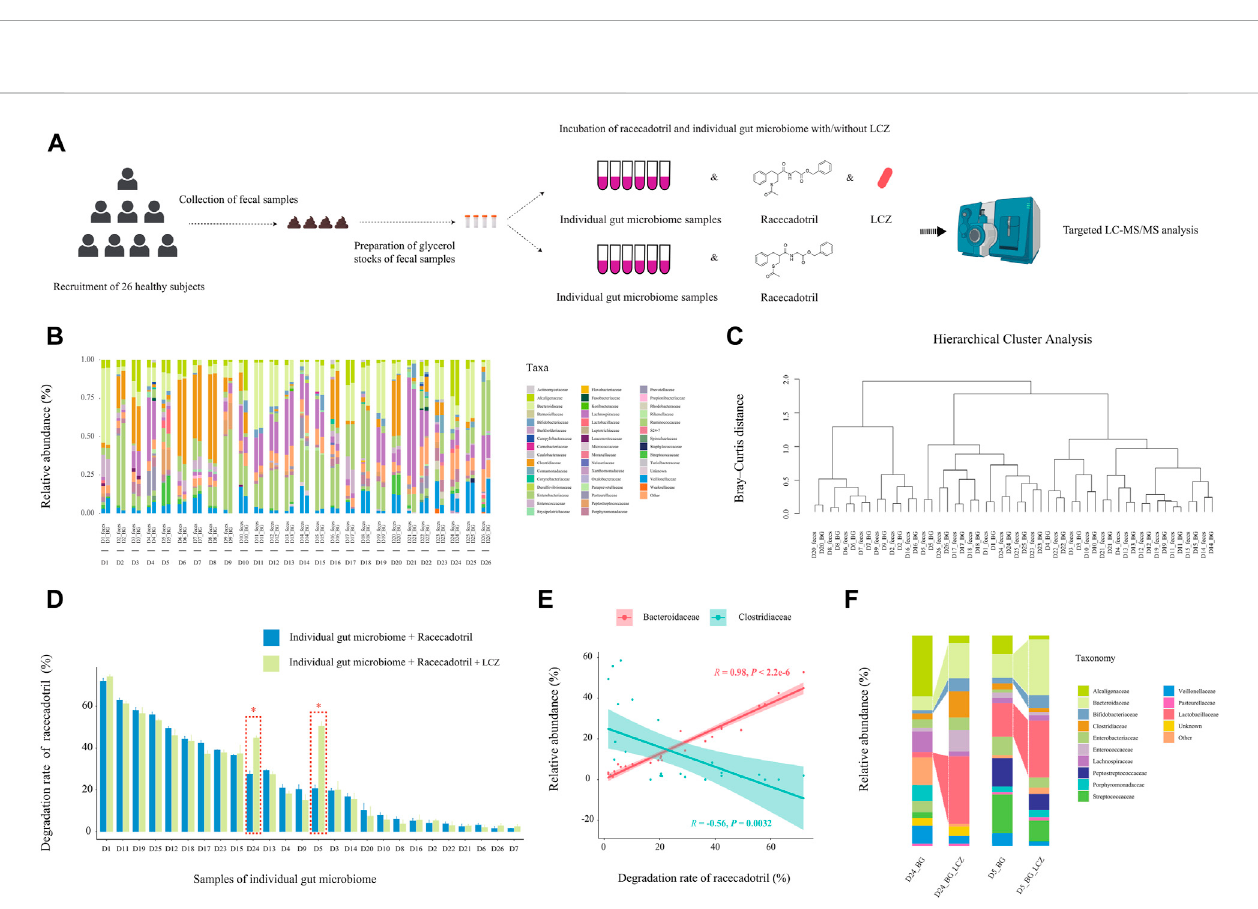
FIGURE 4 Effectofindividualityofgutmicrobiomeon L.casei Zhang(LCZ)-drivendrugdegradation. (A) Schematicillustrationoftheassay. (B) Family-levelbacterial microbiota compositionof fecal samples incomparison with their ex vivo fecal culture counterparts of 26 subjects (D1-26; thepre fi xsample coderepresents the subject number, and the suf fi x code represents type of sample, i.e., feces or ex vivo fecal culture in BG medium [BG]; BG medium comprised liquid BB medium and liquid mGAM medium in a ratio of 7:3). “ Other ” represents taxa that were below 1% of total sequences. (C) Hierarchical cluster analysis of microbiota pro fi le of fecal samples and their ex vivo fecal culture counterparts. (D) The bar chart compares differences in racecadotril degradation rate in ex vivo fecal culture of each individual in the presence/absence of LCZ. The concentration of racecadotril was detected by targeted metabolomics. Error bars represent SD. * adjusted p < 0.05, Wilcoxon test. (E) Correlation (Pearson ’ s) between racecadotril degradation rate and Bacteroidaceae / Clostridiaceae . (F) Family-level bacterial composition of ex vivo fecal cultures of subjects D5 and D24 before and after incubation with LCZ for 24